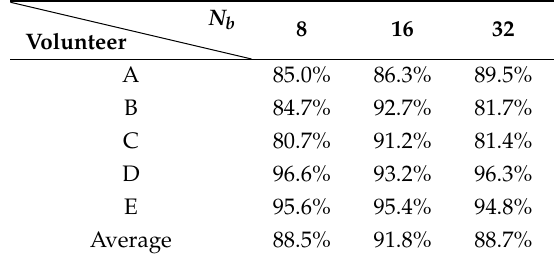
Table 4. Classification accuracies with different numbers of bins.